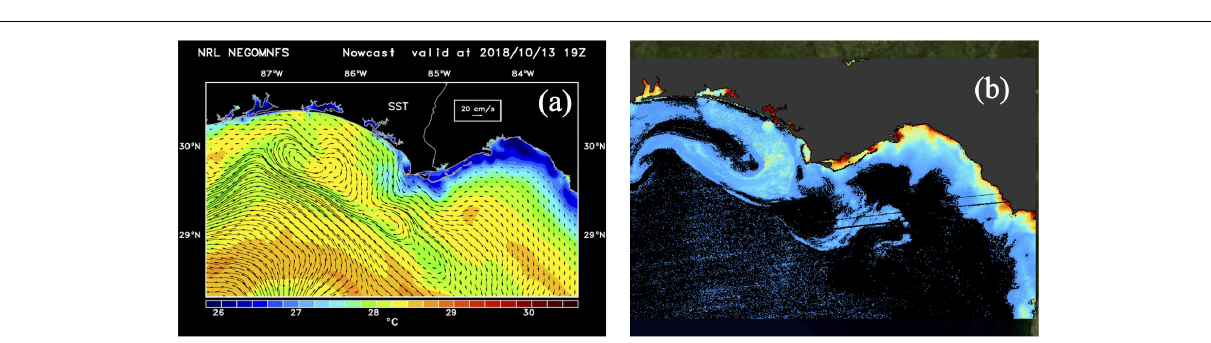
FIGURE 9 | Shelf SST, currents and DOC for 13 October 2018. (a) NCOM model derived sea surface temperature (SST) superimposed with de-tided currents; (b) MODIS-derived DOC